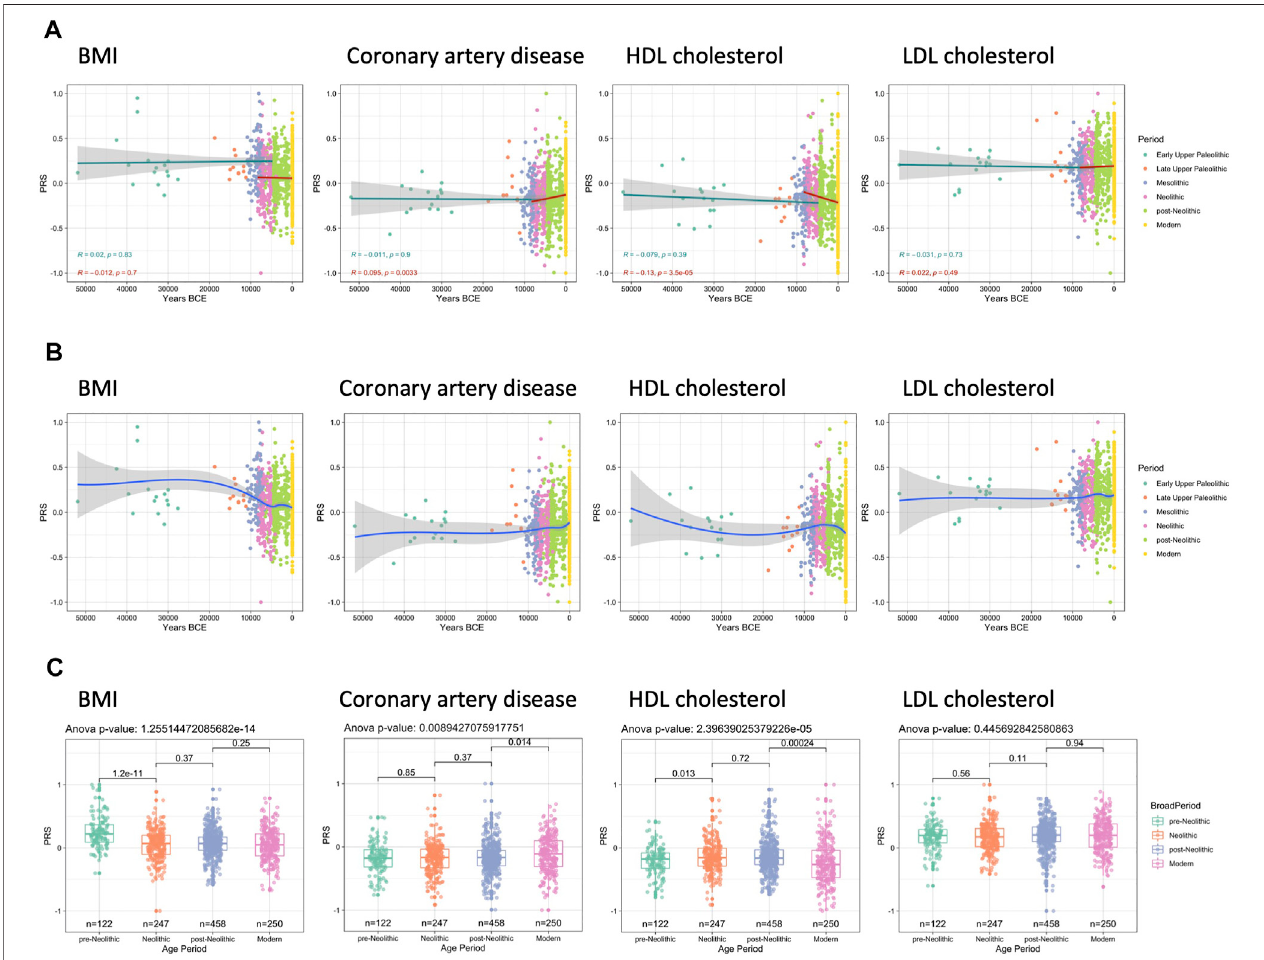
FIGURE2| TrajectoriesofPRSlinkedwithbodymassindex(BMI), coronaryarterydisease,andcholesterol.Maxmissinggenotype per sample:0.96. QTL p value cutoff: 10 – 6 . (A) Prior to the Neolithic revolution no signi fi cant changes in PRS are observed; however, after the start of the Neolithic period a signi fi cant increase in coronary artery disease PRS can be seen as well as a decrease in HDL cholesterol PRS. (B) LOESS regression models show that BMI PRS mostly changes during the Mesolithic and Neolithic, whereas the decrease in HDL cholesterol PRS was mostly occurring in the post-Neolithic and modern era. (C) These differences are also signi fi cant when comparing the different broad periods as a